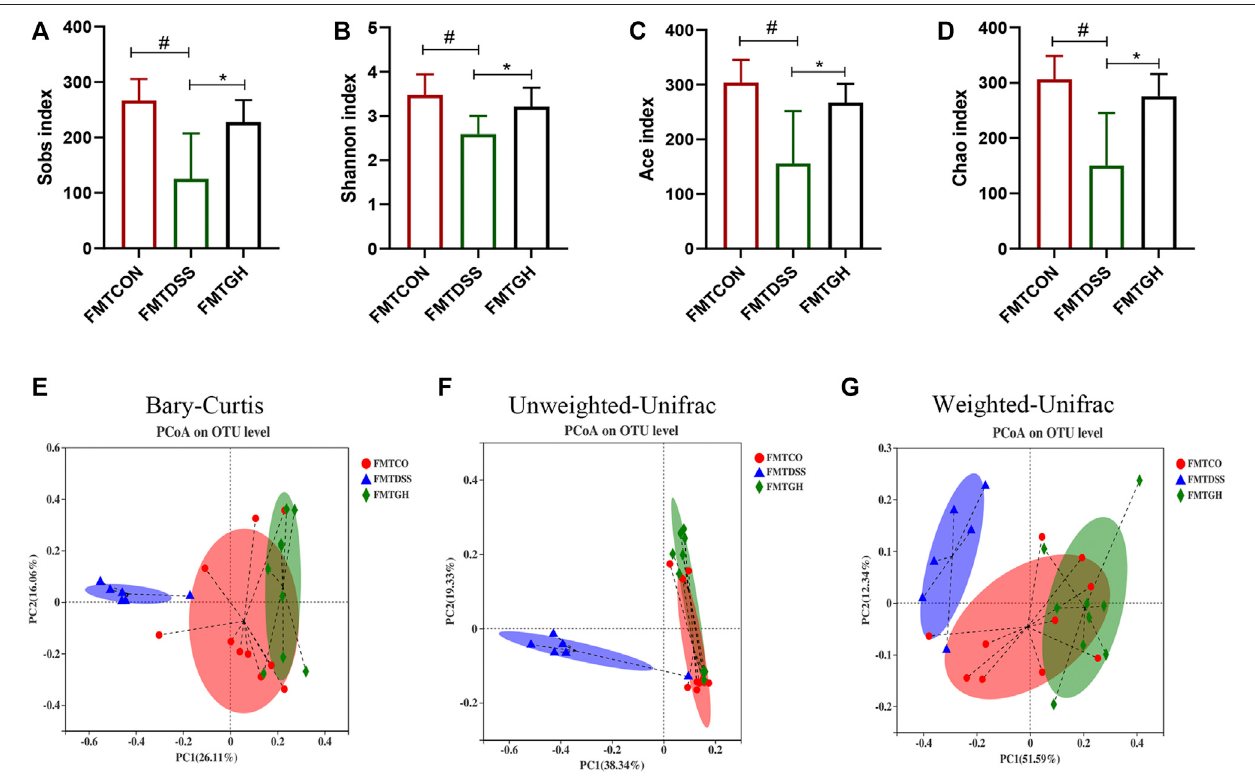
FIGURE6 | FMT changed the gut microbial diversity in colitis mice. (A) Sobs index. (B) Shannon index. (C) Ace index. (D) Chaoindex. (E) PCoA using Bray-Curtis metric distances of beta diversity. (F) PCoA using Unweighted-UniFrac of beta diversity. (G) PCoA using Weighted-UniFrac of beta diversity.